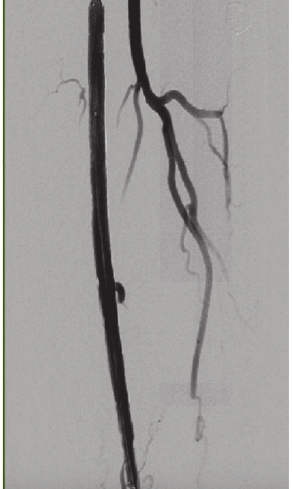
Figure 2: SFA perforated after Glidewire insertion in an attempt to cross the lesion.